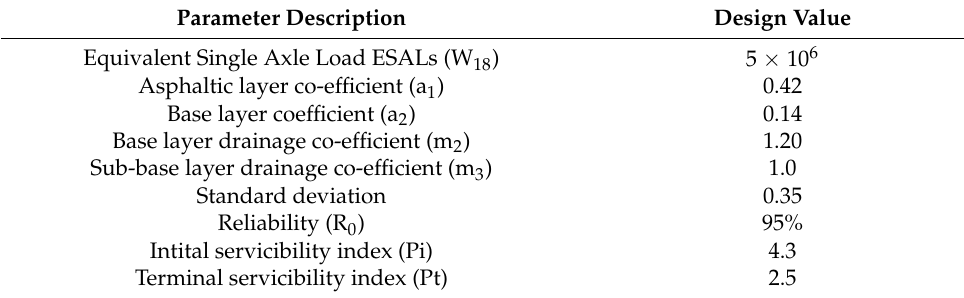
Table 3. Road design parameters for AASHTO gradations B and